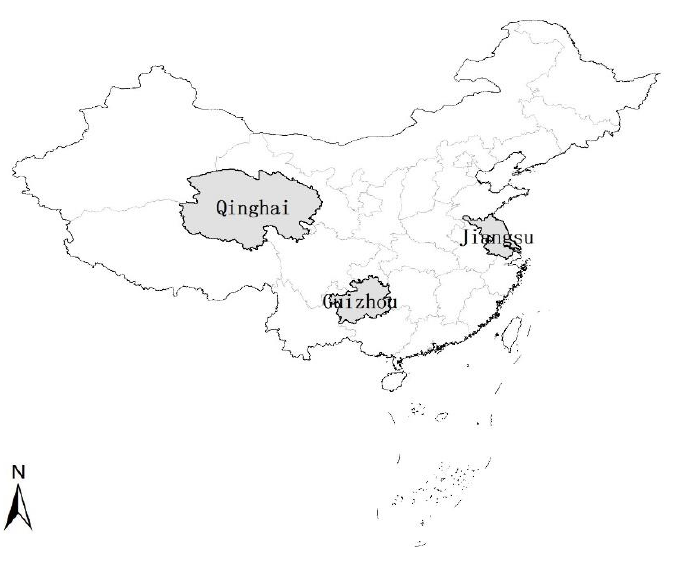
Figure 2. The distribution of the sample provinces in the map of China, and the gray area represents the sample provinces.